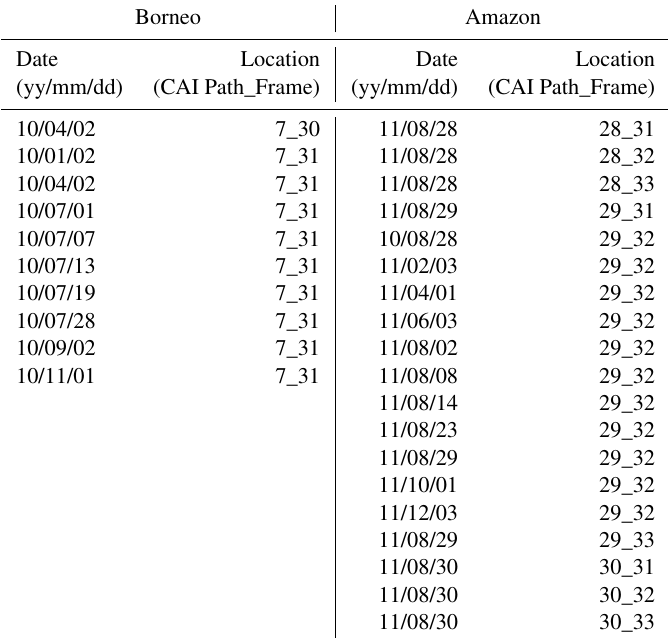
Table 3. GOSAT CAI L1B product and CAI L2 cloud flag product used for rainforests in this study. Borneo Amazon